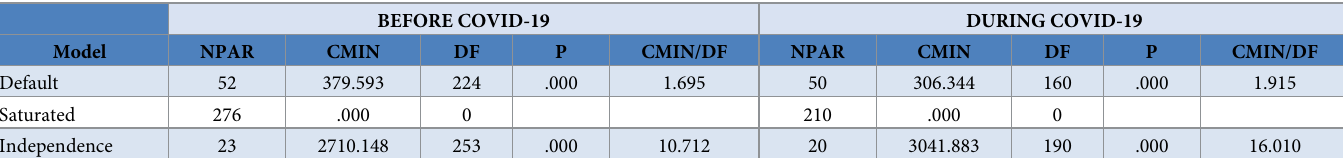
Table 2. CMIN index.